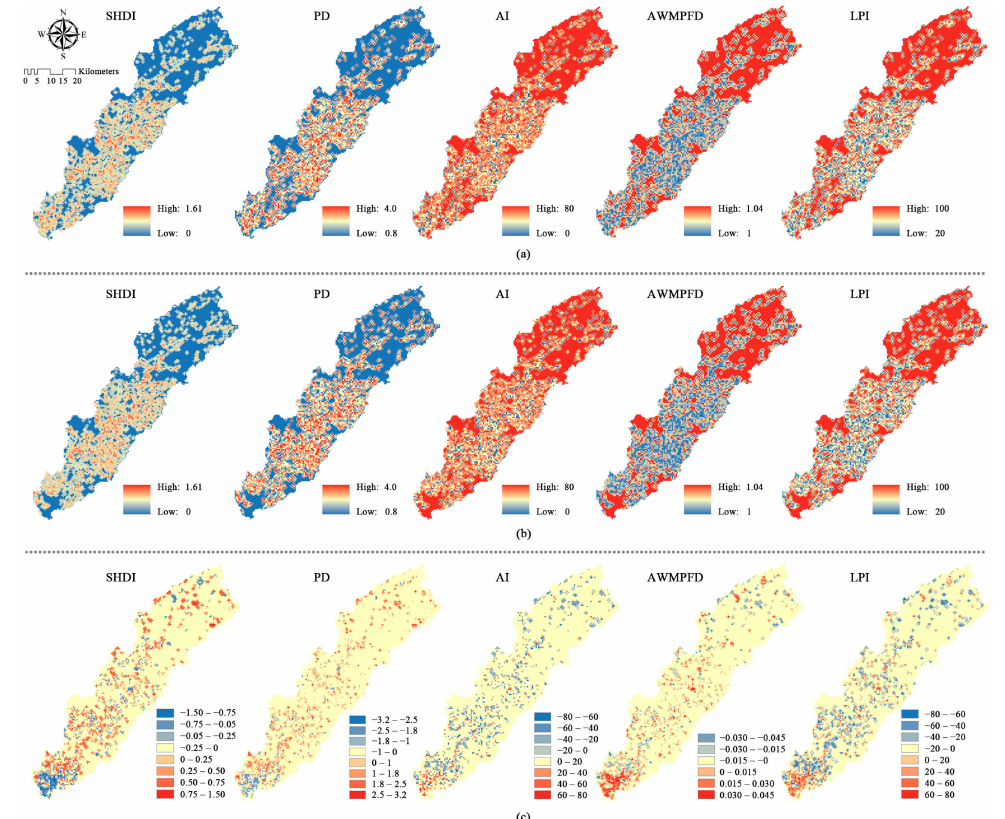
Figure 6. Spatial distribution of the changes in landscape metrics between ( a ) 1980 and ( b ) 2015, and ( c ) showed the results of subtraction of the indices in 1980 from